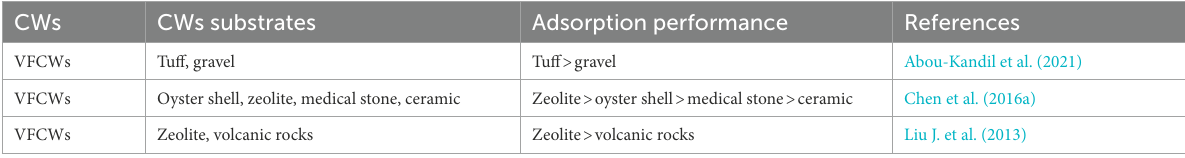
TABLE 2 Comparison of adsorption performance of CWs